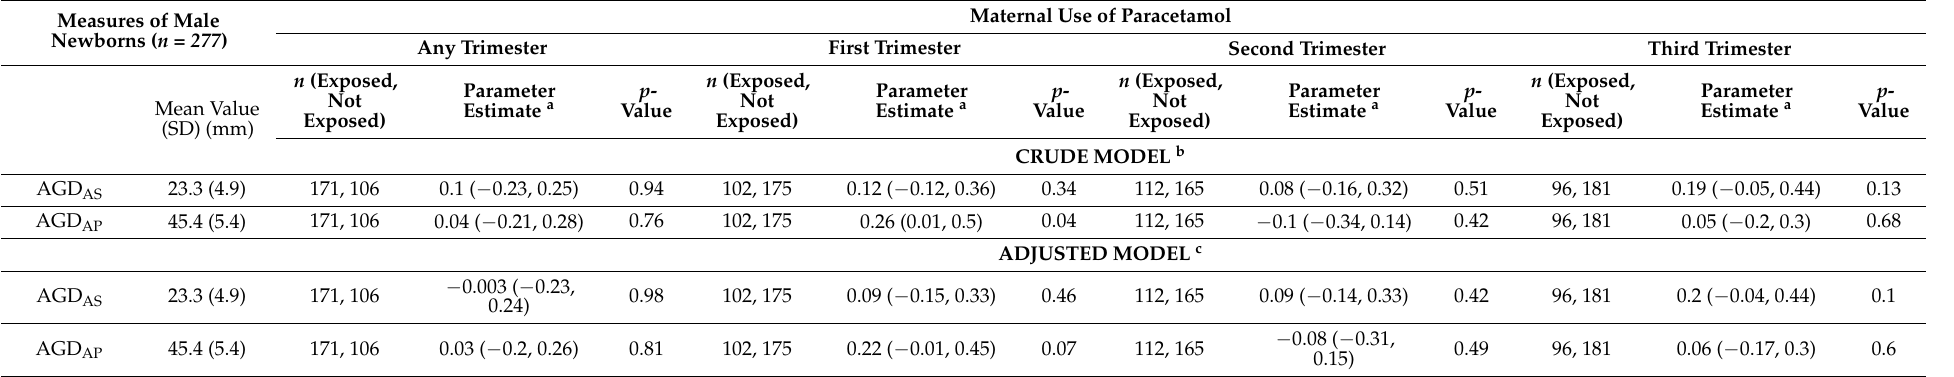
Table 3. Unadjusted and adjusted linear regression models of male anogenital distance according to the maternal use of paracetamol in pregnancy. p -value ≤ 0.05 is considered statistically significant. Measures of Male Newborns ( n = 277